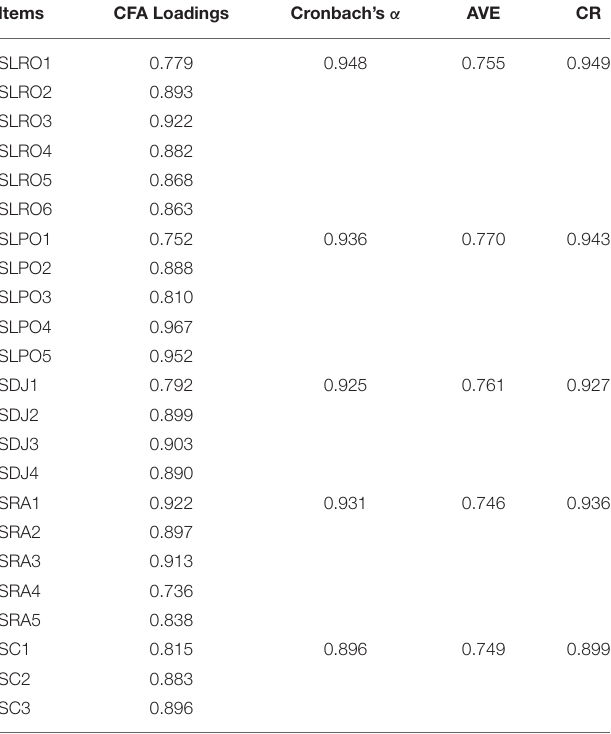
TABLE 2 | Results of reliability analysis and CFA ( n =